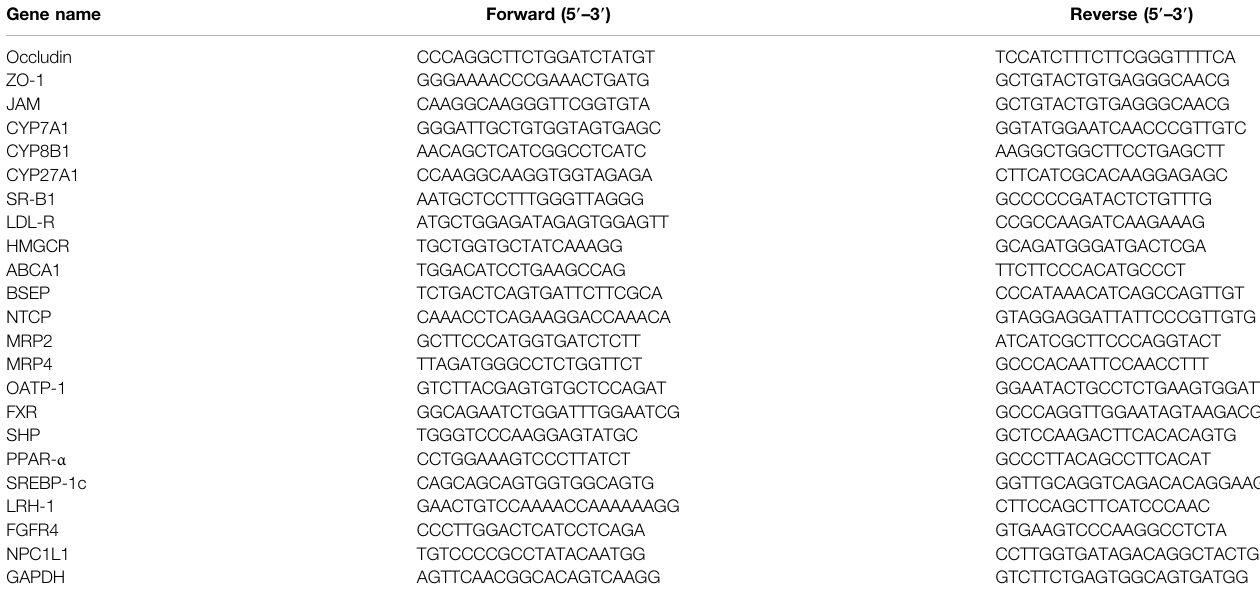
TABLE 2 | RT-qPCR primer sequences.